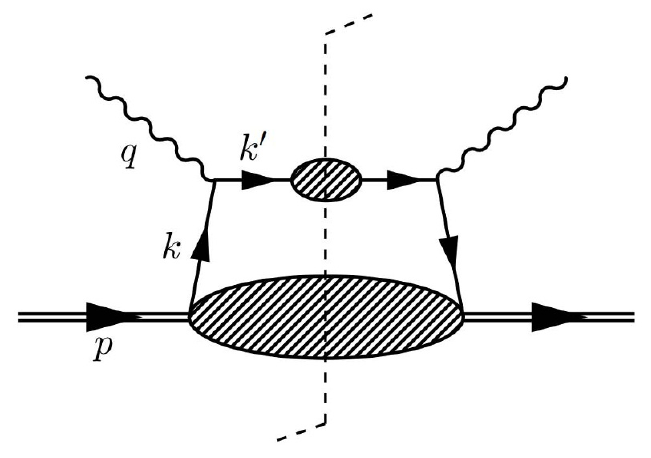
Figure 1 . Depiction of the dominant contributions to the hadronic tensor of the DIS process. The upper portion of the graph represents the tree-level perturbative process with (cid:12)nal-state interactions denoted by the small hatched ellipse, which can be neglected in practice. The larger hatched ellipse denotes the e(cid:11)ective long-distance physics encapsulated by the PDFs. The dashed line bisecting the diagram indicates summation over (cid:12)nal hadronic states and placing intermediate states on mass 2 shell, e k 0 =